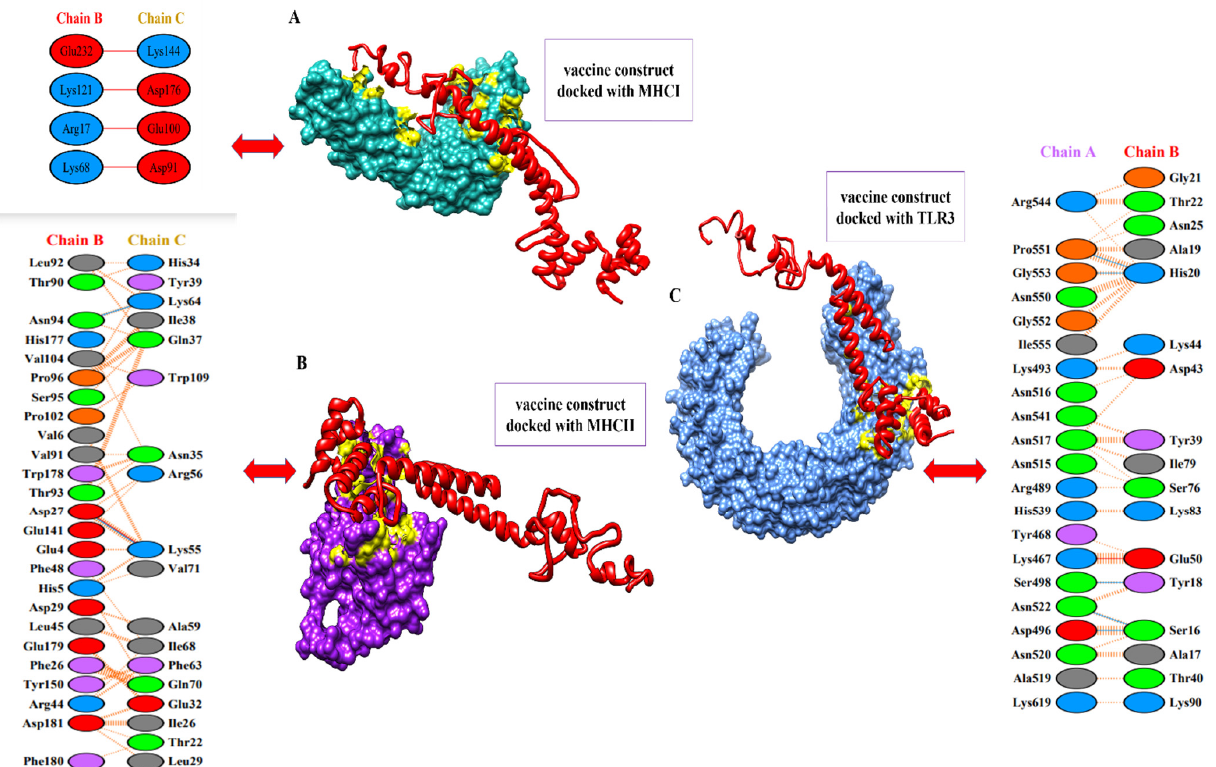
Figure 10. Docked complexes of the vaccine to MHC-I, MHC-II, and TLR-3 receptor molecules. ( A ) The designed vaccine construct with the MHC-I molecule, along with interactive amino acid residues. ( B ) The image represents the designed vaccine construct with the MHC-II molecule, along with interactive amino acids residues. ( C ) The image represents the designed vaccine construct with the TLR-4 molecule, along with interactive amino acids